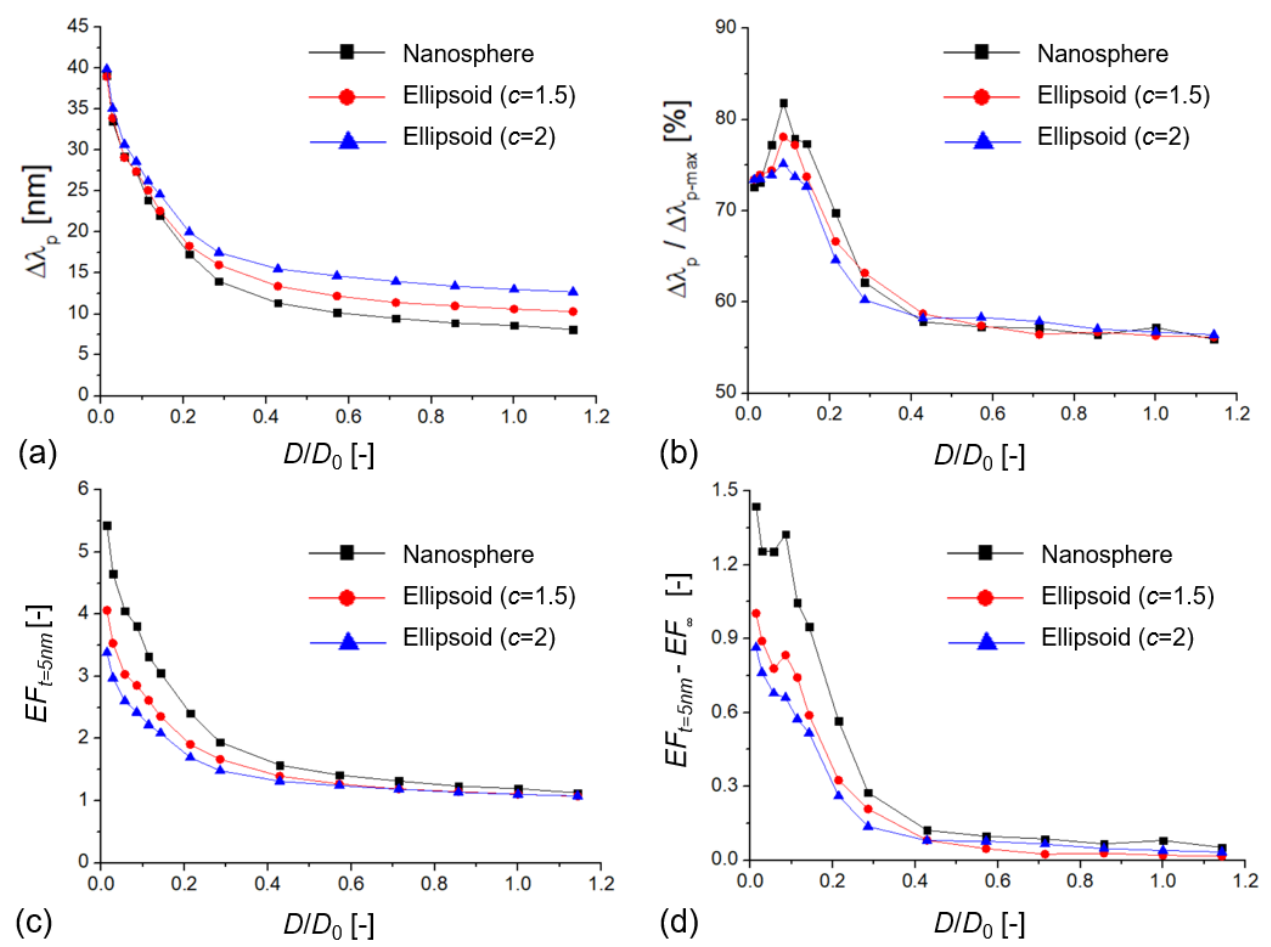
Figure 6. ( a ) Extinction peak shift ( ∆ λ p ) of different dimer arrangements as a function of the dimensionless D / D 0 value ( D 0 = 70 nm) with a dielectric layer of 5 nm ( n l = 1.5 in water medium, with n = 1.33). ( b ) Relative extinction peak shift as a function of the dimensionless D / D 0 value, where ∆ λ p − max is calculated as the peak shift upon the RI of the medium changing from 1.33 to 1.5. ( c ) Enhancement factor ( EF t =5nm ) as a function of D / D 0 . ( d ) Difference between surface and bulk enhancement factors ( EF t =5nm − EF ∞ ) as a function of D / D 0 .